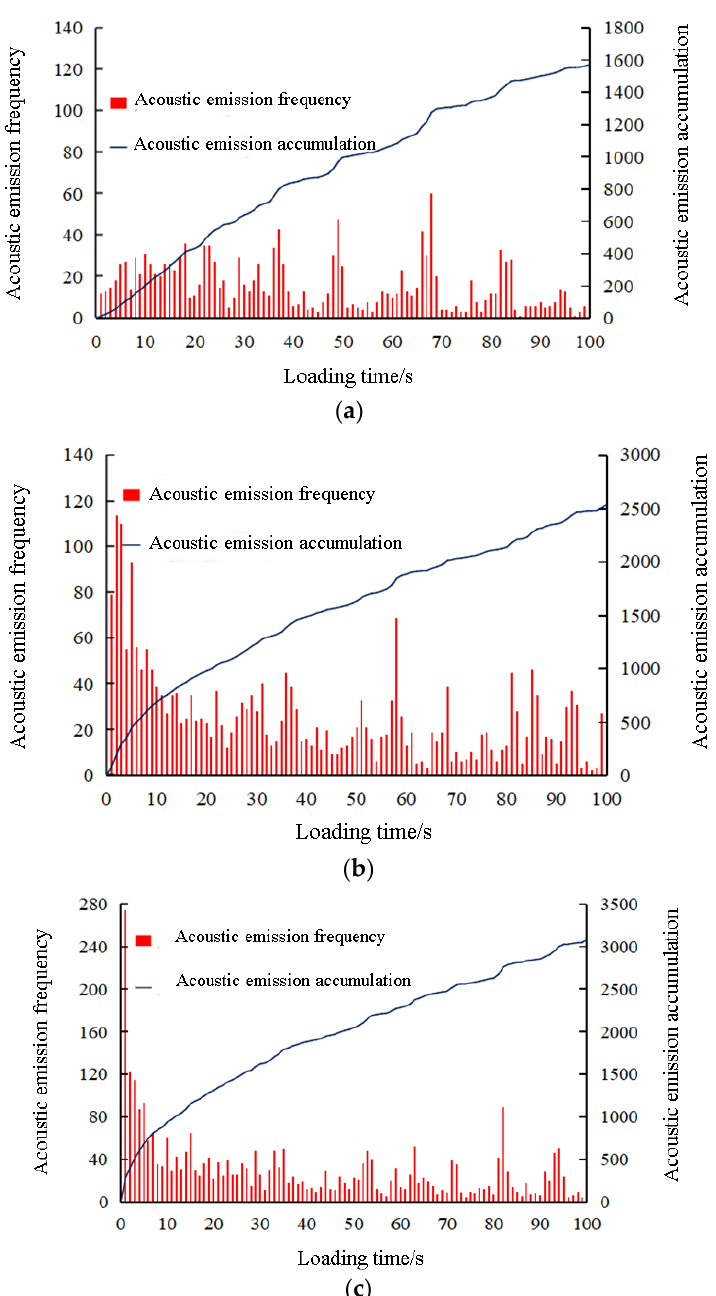
Figure 19. Acoustic emission changes under the condition of thermal shock by soaking the specimen in liquid. ( a ) Heat transfer coefficient H = 100; ( b ) heat transfer coefficient H = 500; ( c ) heat transfer coefficient H = 1000.